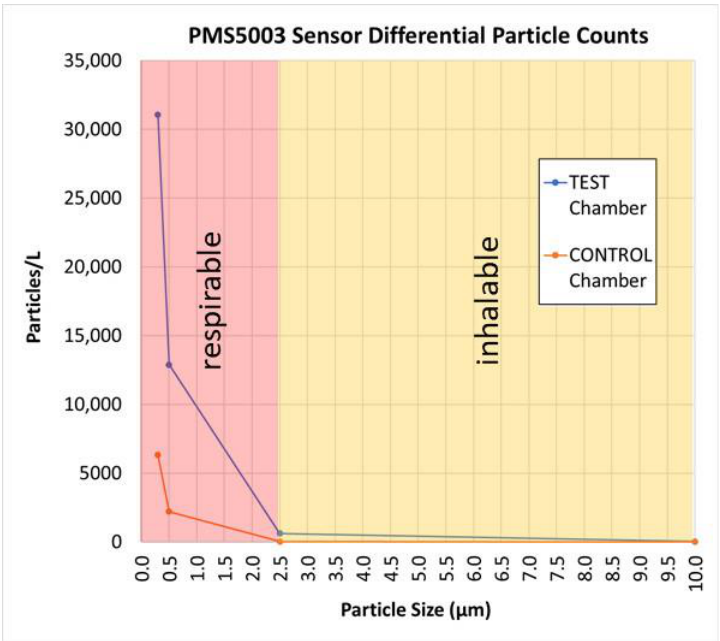
Figure 15. Graph showing measured 0.3, 0.5, 2.5, and 10 µm dust particle counts in the test and control chambers.